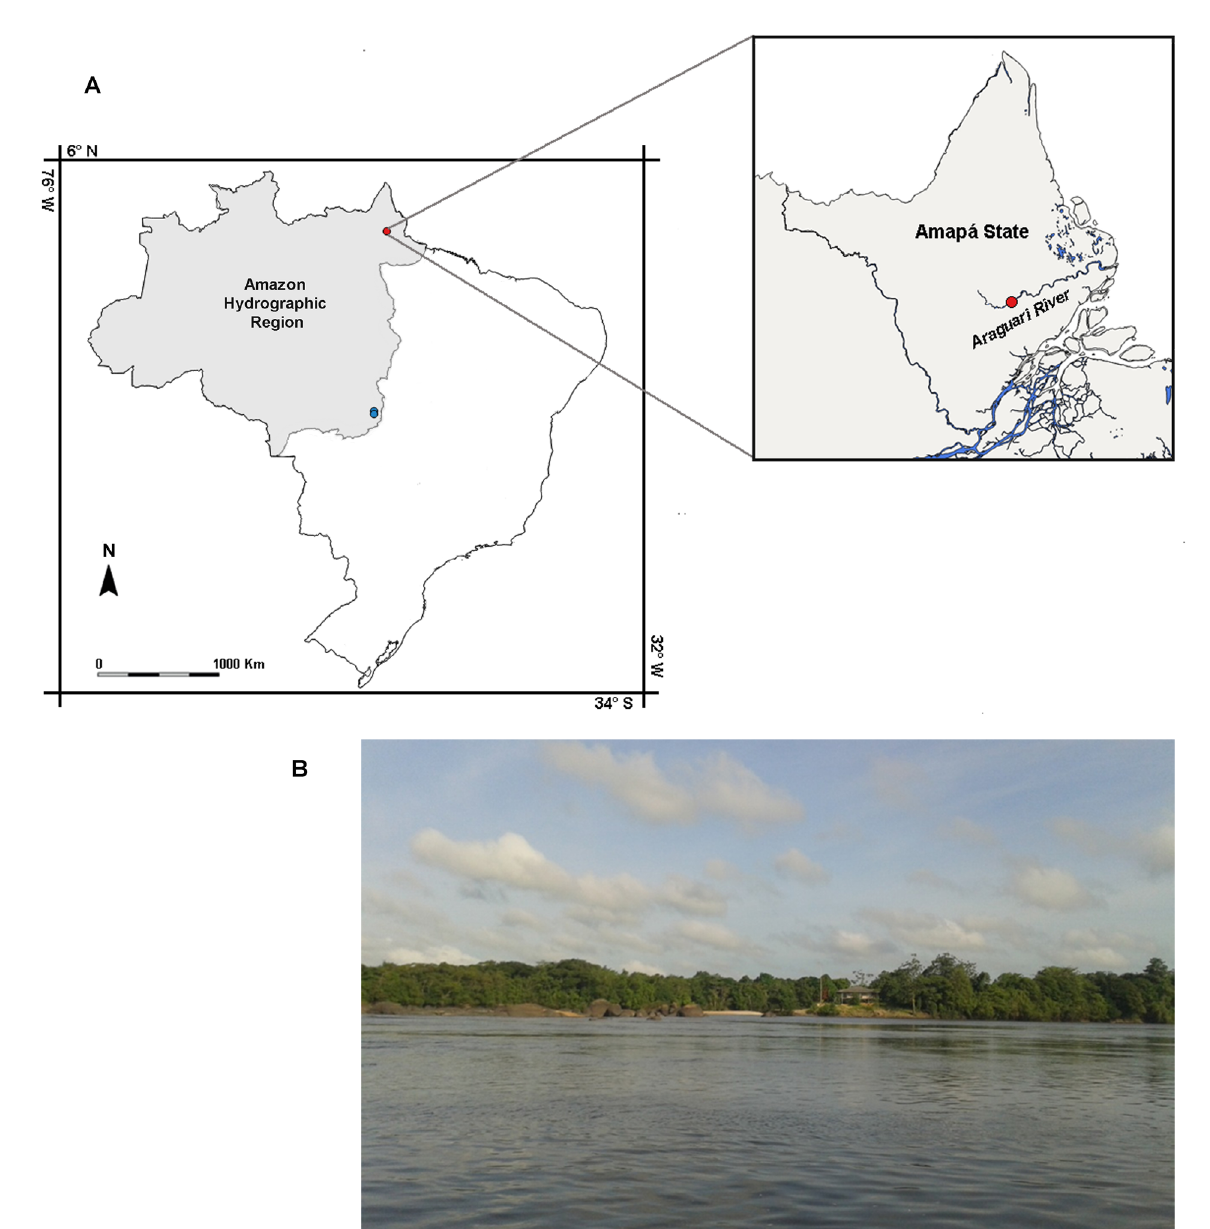
Figure 1. Occurrence of Kisakiellus aweti in Brazil. A, Previous (blue) and the present (red) records in Brazil; B, general aspect of the site where the specimen was collected, Araguari